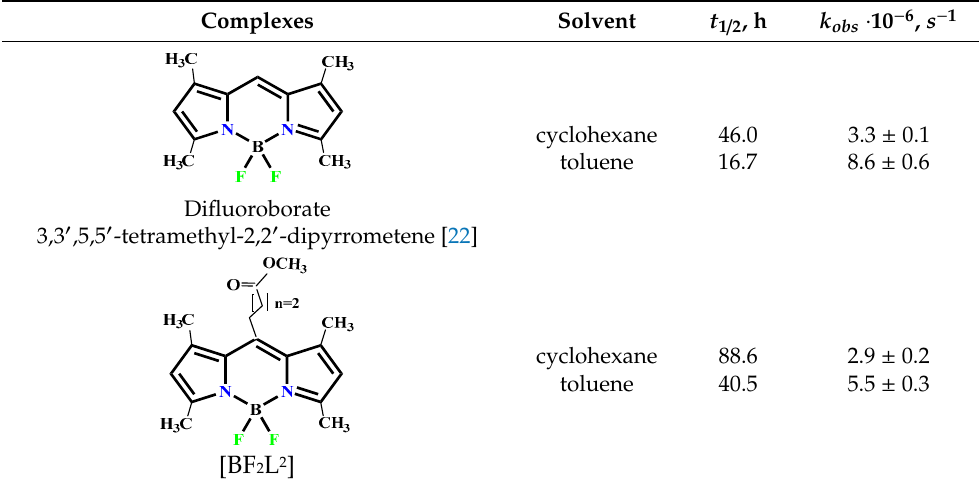
Figure 3. The changes of the electronic absorption ( a ) and fluorescence ( b ) spectra of a [BF 2 L] solution in toluene under UV irradiation .